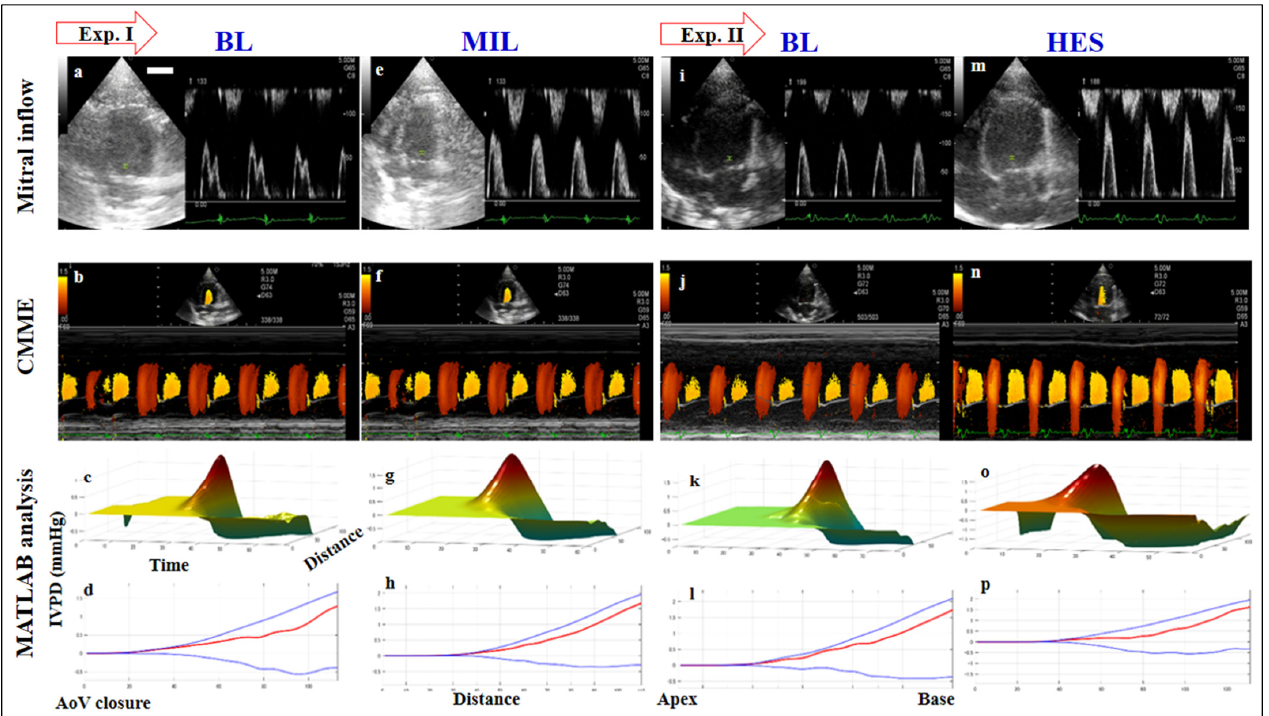
Figure 3. The echocardiography and IVPD (IVPG) in rats. Images in each column were captured from the same rat. In the first experiment, the heart function was evaluated at the baseline ( a – d ) and after milrinone (MIL, e – g ). In the second experiment, measurements were recorded at the baseline (BL, i – l ) and after hydroxyethyl starch infusions (HES, m – p ). Firstly, the mitral inflow was evaluated in all groups by pulsed-wave Doppler echocardiography from the left apical 4-chamber view ( a , e , i , m ) that showed significantly increased E-wave after HES infusion. Color m-mode echocardiography (CMME) was switched on and photos were captured ( b , f , j , n ) for further calculation. The IVPD was calculated by MATLAB software using in-house coding, and the three-dimensional temporal and spatial profiles of the left ventricular IVPD was obtained where the time, IVPD, and distance were determined ( c , g , k , o ). Subsequently, the IVPD (IVPG) in early diastole was identified ( d , h , i , p ). The top (blue), middle (red), and bottom (blue) lines represent inertial, total, and convective IVPD,